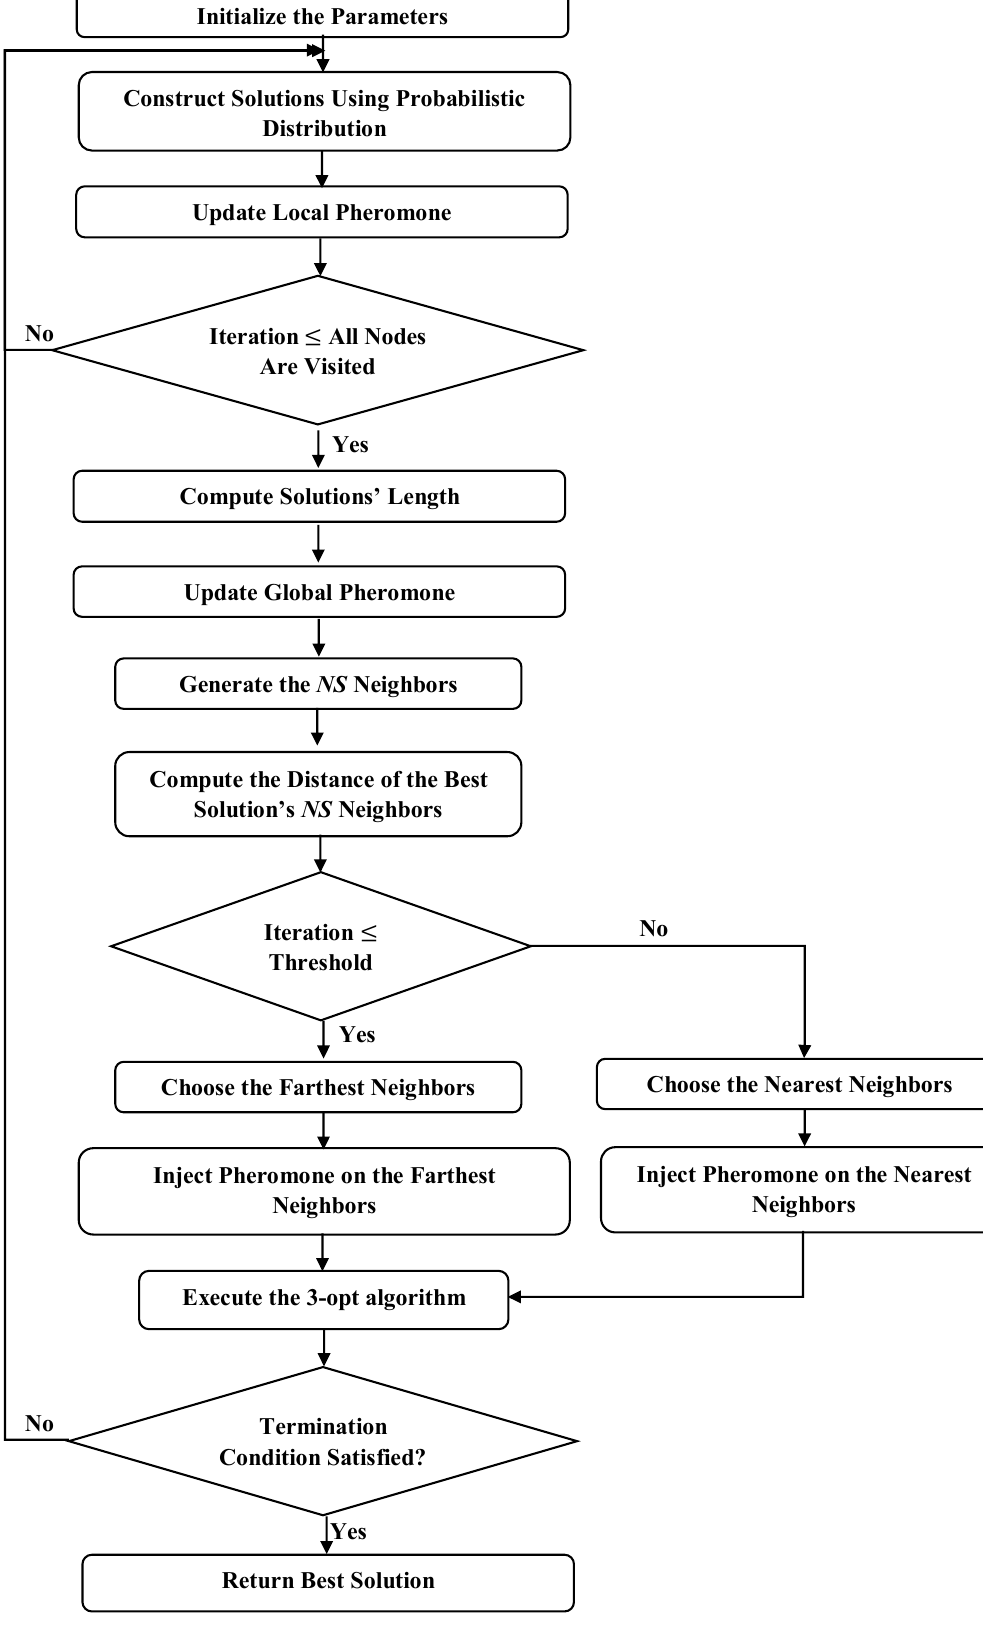
Figure 5. DFACO flowchart.